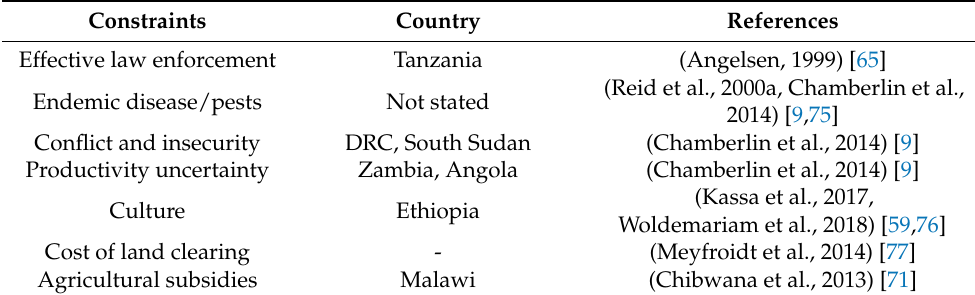
Table 5. Constraints to agricultural